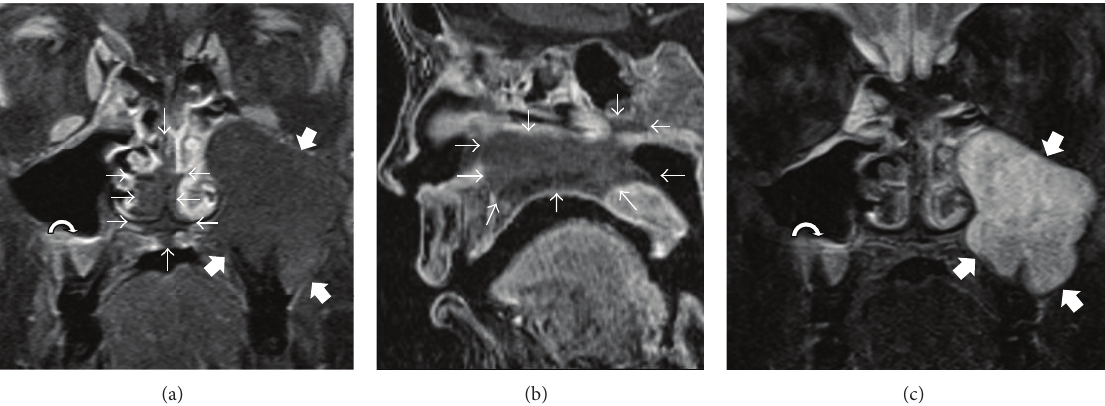
Figure 1: (a) Coronal postcontrast fat-saturated T1-weighted images (T1WI) and (b) sagittal postcontrast T1WI demonstrate sharply delineated hypoenhancement of the nasal septum and bilateral inferior turbinates extending inferiorly to the hard palate and superiorly to the inferior aspect of the sphenoid body (outlined by small arrows) without significant associated mucosal edema on STIR images (c). An odontogenic cyst centered on the crown of a left maxillary molar fills and expands the left maxillary sinus (thick arrows). A smaller maxillary odontogenic cyst is present on the right (curved